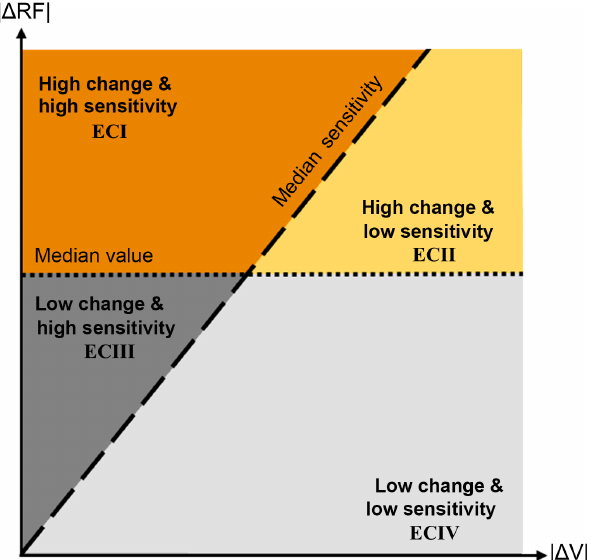
Figure 3. Categorization of the effect of changes in forcing vari- ables ( V ) on runoff (RF). The four areas correspond to the four de- fined effect categories. The x axis corresponds to relative changes in forcing variables and the y axis to relative changes in runoff. For all changes, the absolute value is considered.